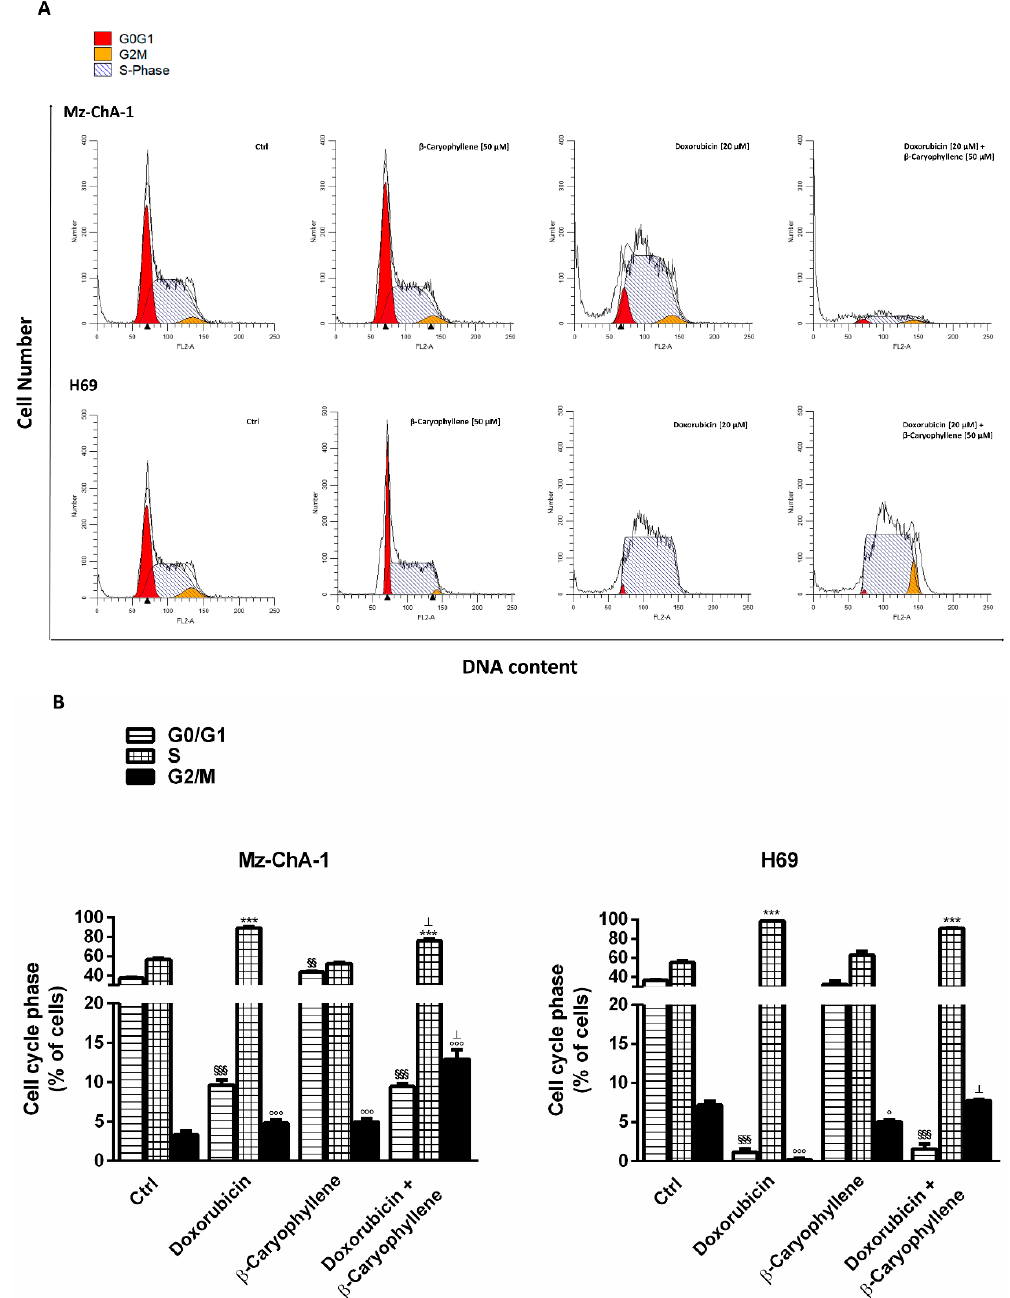
Figure 7. Effect of the natural sesquiterpene β -caryophyllene (50 µM), doxorubicin (20 µM) and their combination compared the control on the cell cycle progression in Mz-ChA-1 cholangiocarcinoma cells and H69 noncancerous cholangiocytes. The cells were treated for 24 h, then the pellets were harvested, fixed with 70% ethanol and stained with propidium iodide for the cytofluorimetric analysis. ( A ) Representative histograms showing the percentages of cells in different cell cycle phases after treatments in Mz-ChA-1 and H69 cells. ( B ) Bar graph analysis obtained from at least two independent replicates (data expressed as mean ± standard error). §§ p < 0.01 and §§§ p < 0.001 (one-way ANOVA followed by Dunnett’s multiple comparison post-test) denote a significant difference of G0/G1 phase in the treatments compared the control. *** p < 0.001 (one-way ANOVA followed by Dunnett’s multiple comparison post-test) denotes a significant difference of S phase in the treatments compared the control.). ° p < 0.05 and °°° p < 0.001 (one-way ANOVA followed by Dunnett’s multiple post-test) denotes a significant di ff erence of G2 / M phase in the treatments compared the control. ⊥ p < 0.001 (t-Student test) denotes a significant di ff erence with respect to